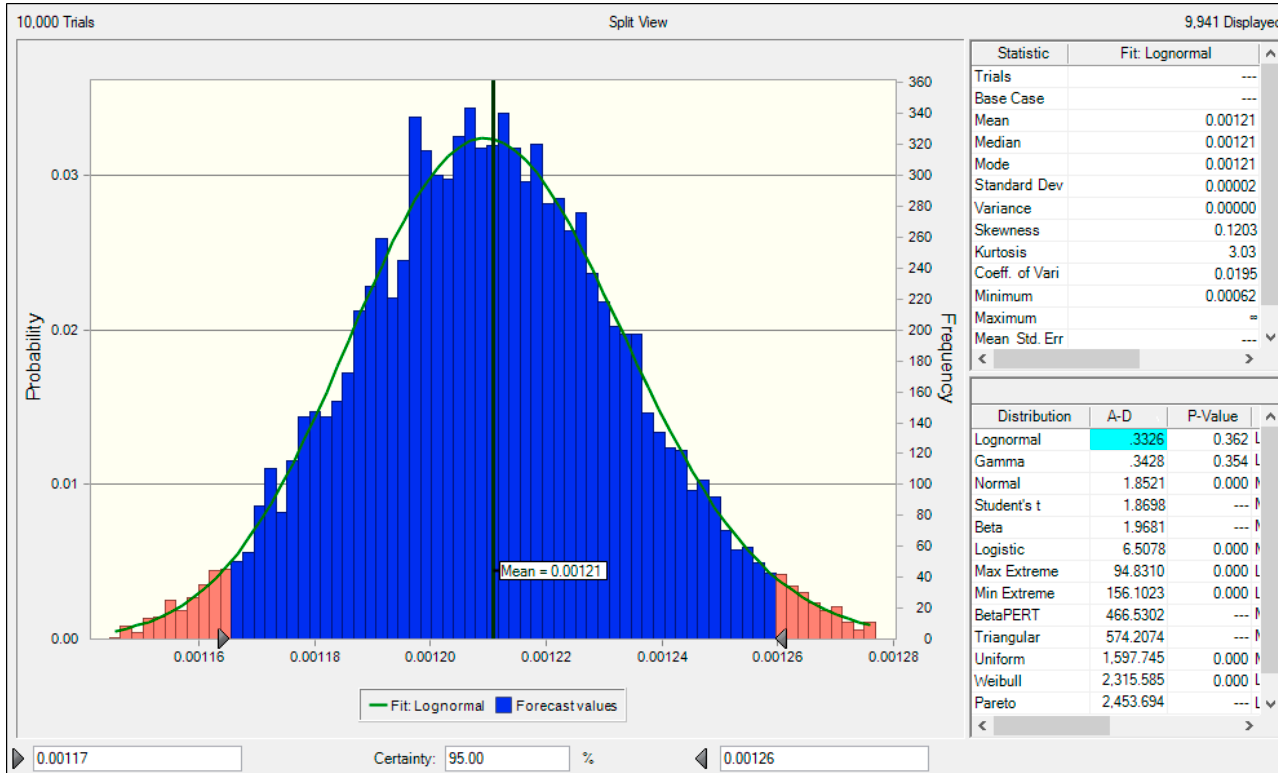
Figure 4. Uncertainty of NPK fertilizer production facilities NH 3 emission factor.